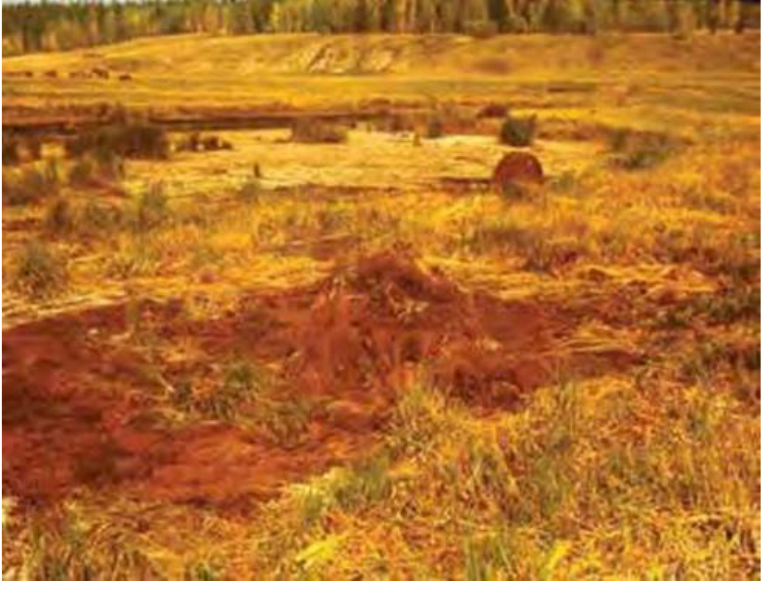
Figure 3. Mounds of peat mass on the shore of a drying alas lake.